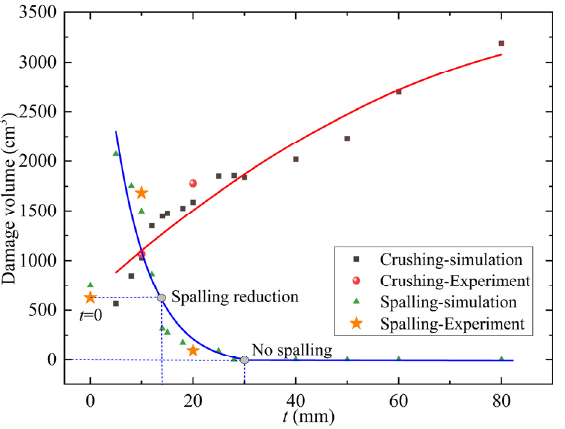
Figure 19. Experimental and simulation results of the volume of crushing and spalling